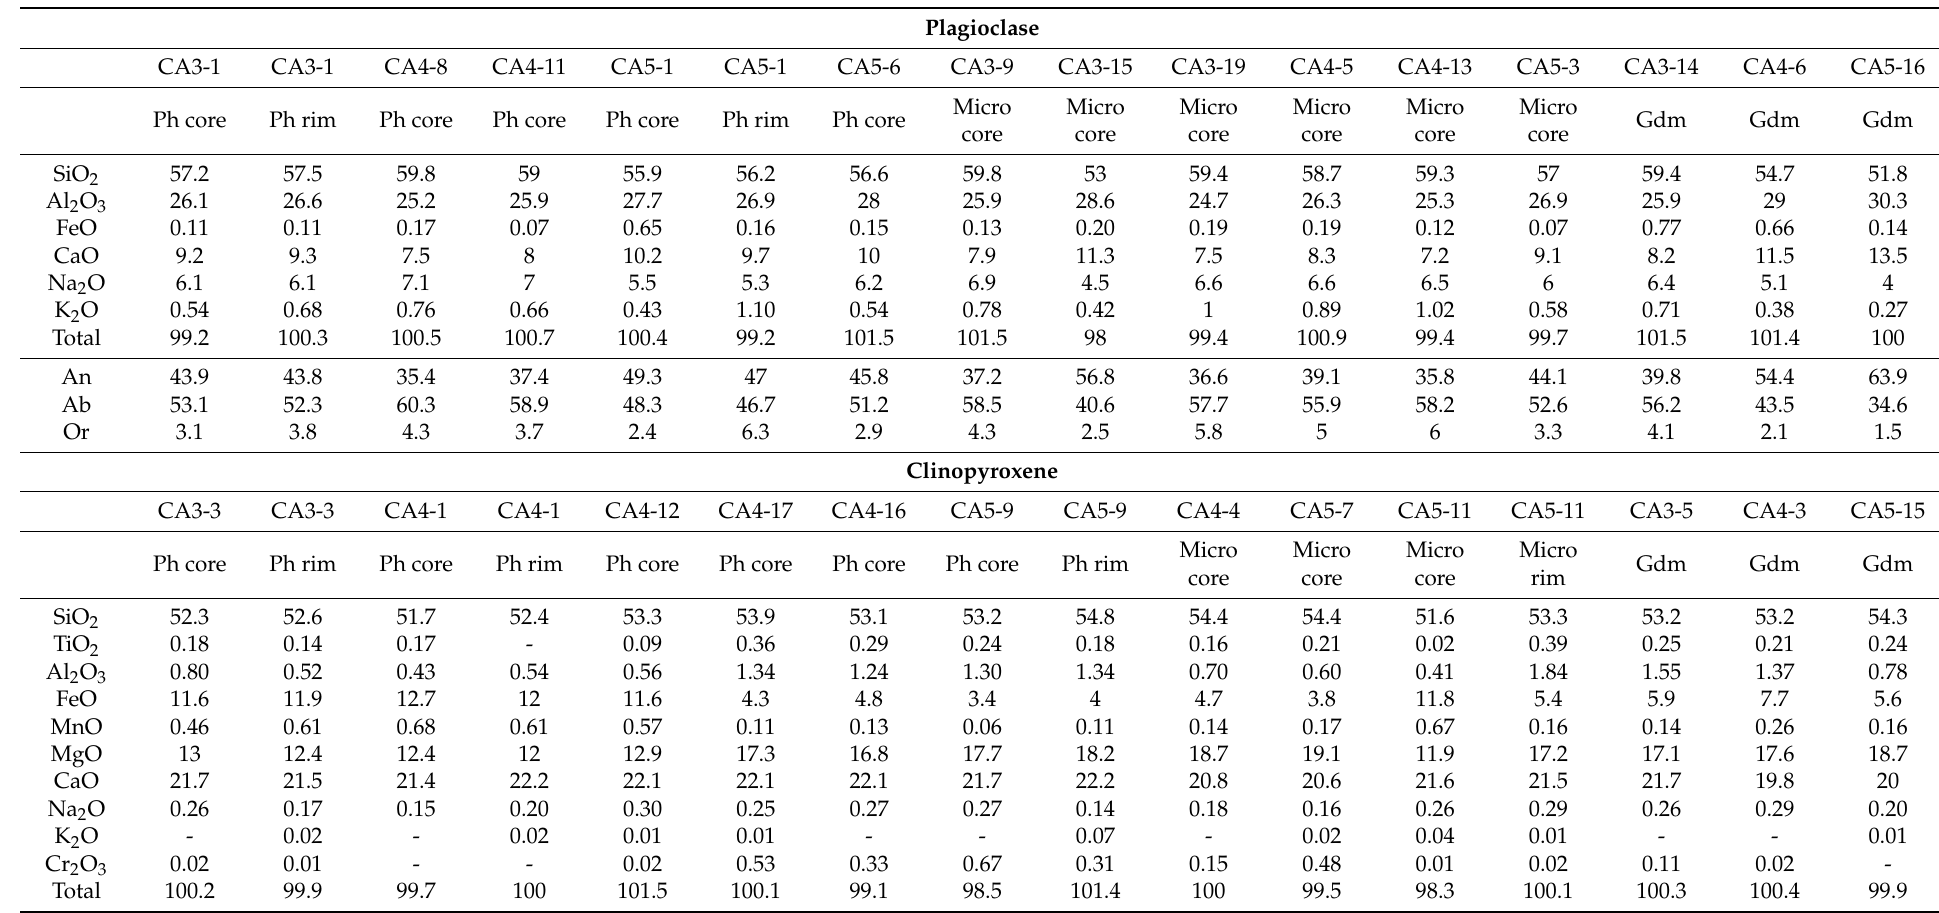
Table 1. Representative chemical analyses of the main mineral phases from the Laghetto